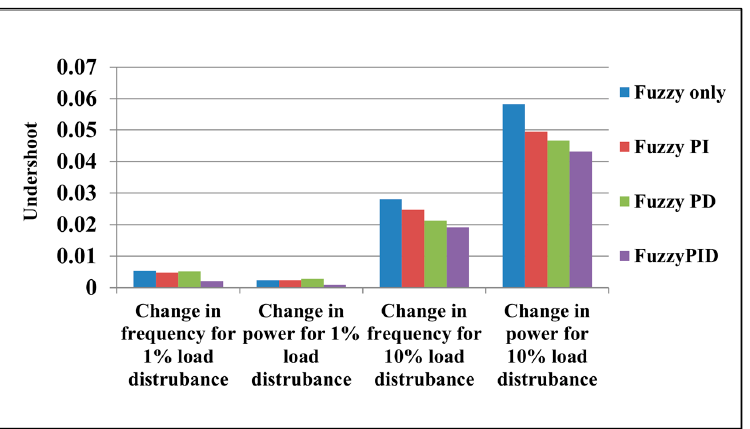
Figure 18. Comparison of dynamic responses of the hybrid system in terms of undershooting (p.u) for frequency and power of the hybrid system with Fuzzy, Fuzzy-‘PI’, Fuzzy-‘PD’ and Fuzzy-‘PID’ against different load disturbances.